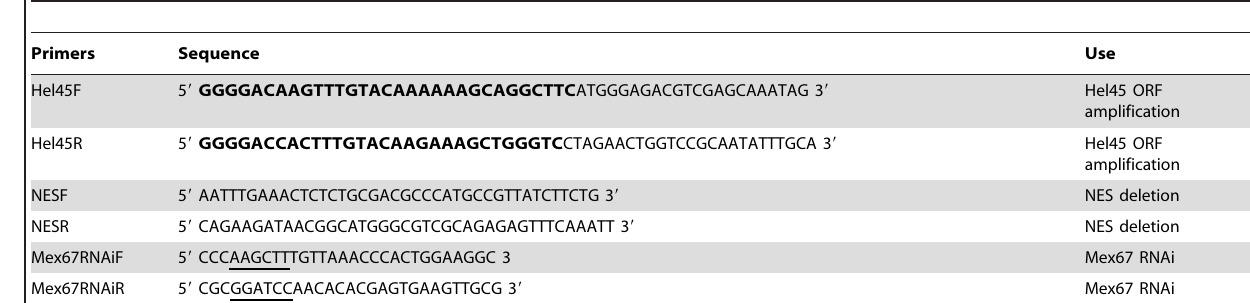
Table 1. Oligonucleotides used for PCR.